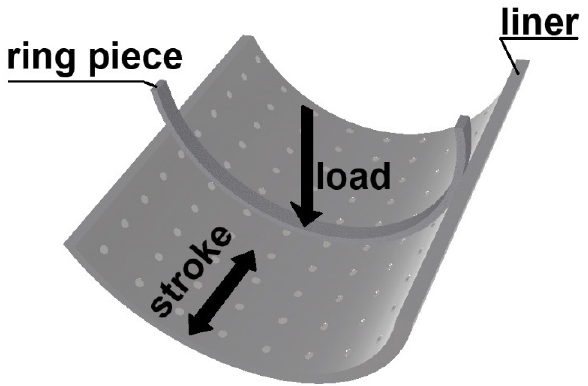
Figure 1. Typical configuration of laboratory tests.